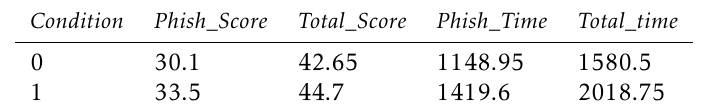
Table 6. Monetary Incentive Analysis